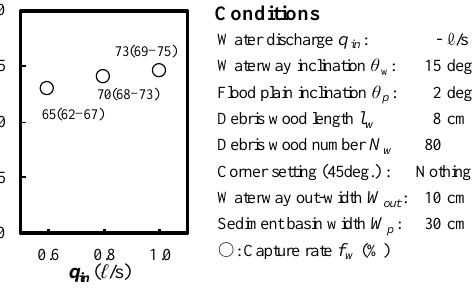
Figure 18. Effect of different basin shape/configuration (corner installation) on the flow conditions and capture function of the basin. ( Left : with corners; right : without corners).